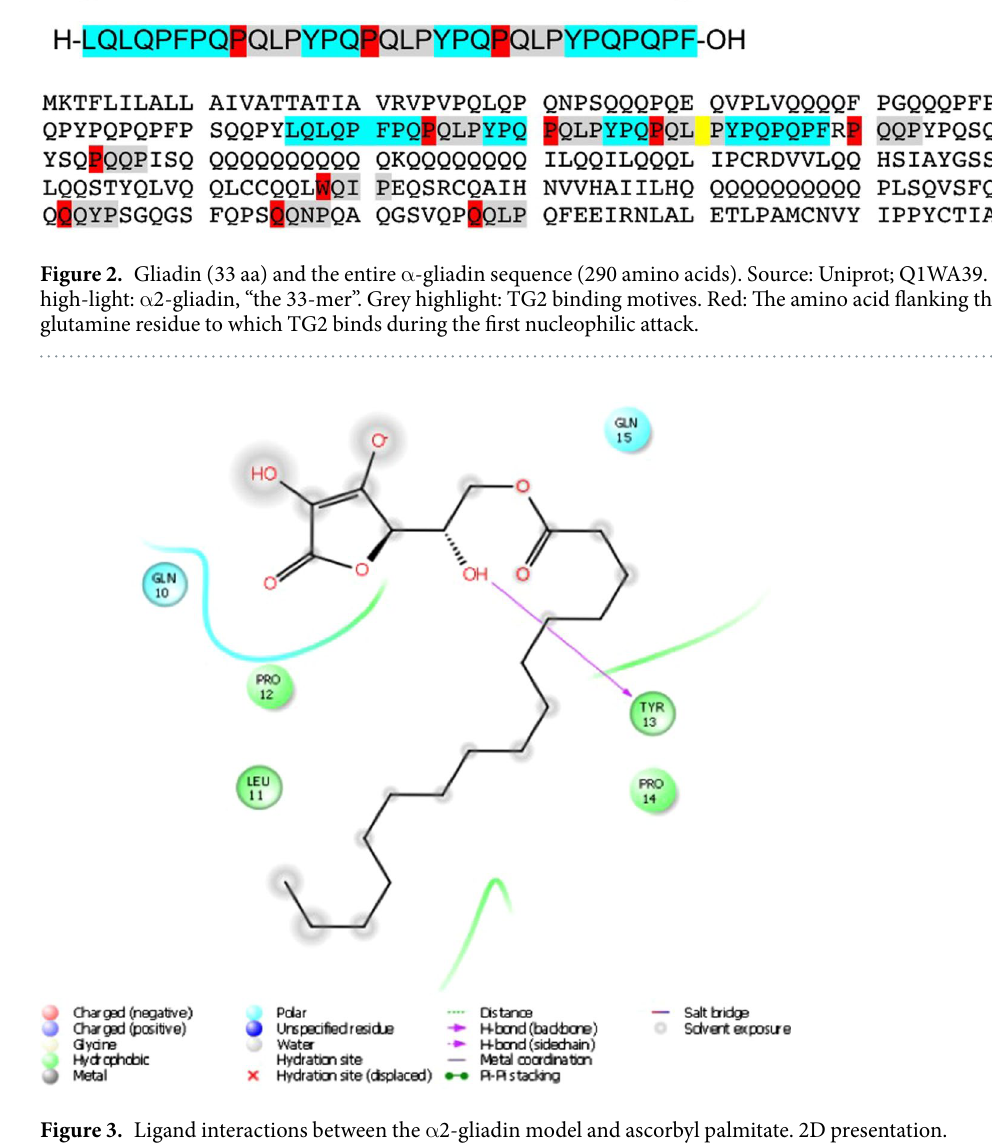
Figure 3. Ligand interactions between the α 2-gliadin model and ascorbyl palmitate. 2D